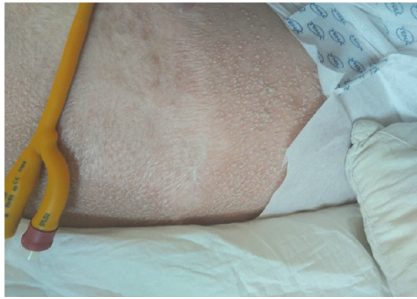
Figure 2: Numerous, pinhead-sized, nonfollicular, sterile pustules, arising on an erythematous and edematous